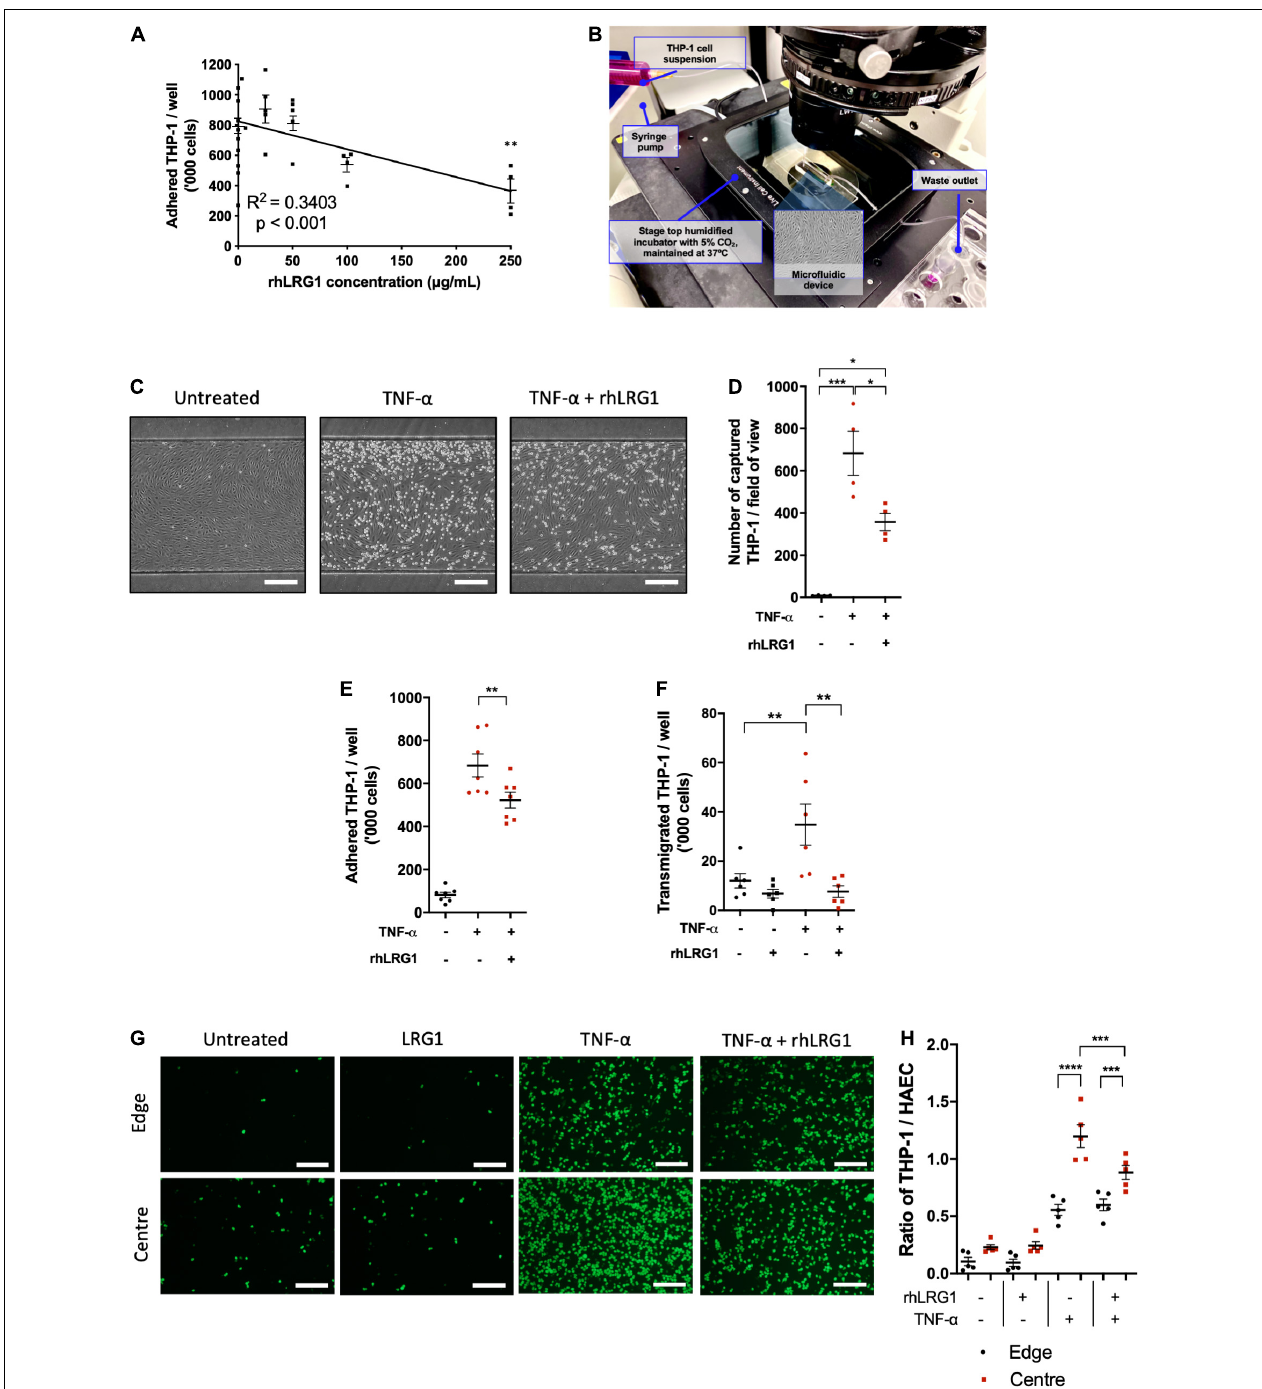
FIGURE 3 | Recombinant human LRG1 (rhLRG1) suppressed THP-1 recruitment on TNF- α -activated EC. (A) rhLRG1 treatment suppressed THP-1 adhesion on HUVECs activated by TNF- α in a dose-dependent manner. Additional statistical testing compared each dose with non-treated cells, ns = not significant. (B) Setup of the THP-1 capture assay using a microfluidic chip. (C) Representative images of THP-1 captured on HUVECs under flow in a microfluidic chip. Scale bar = 100 µ m. (D) rhLRG1 treatment prevented TNF- α -induced THP-1 capture on HUVECs under laminar flow in a microfluidic chip. (E) rhLRG1 treatment decreased TNF- α -induced THP-1 adhesion to HAECs. (F) rhLRG1 treatment prevented TNF- α -induced THP-1 migration across HAEC monolayers. (G) Representative images of Calcein-AM-stained THP-1 adhered to HAECs with different treatment and shear conditions. Scale bar = 200 µ m. (H) THP-1 adhesion to HAECs sheared using a swirling well plate. rhLRG1 significantly suppressed TNF- α -induced THP-1 adhesion under putatively atherogenic flow. (One-way ANOVA followed by Bonferroni post hoc test; n ≥ 4. * p < 0.05; ** p < 0.01; *** p < 0.001; **** p < 0.0001).